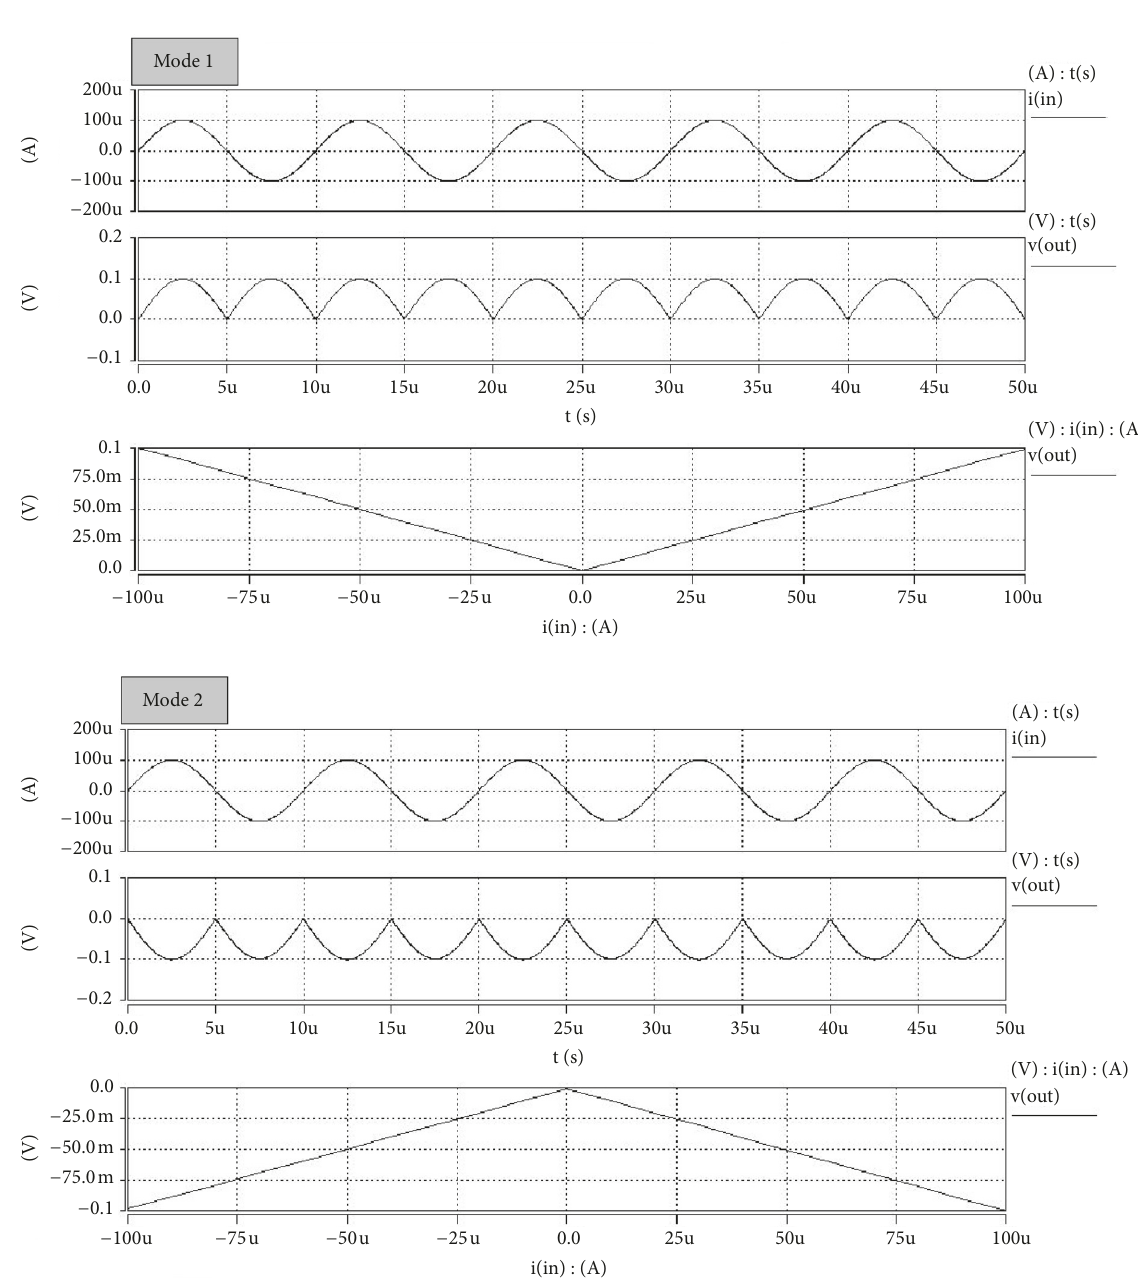
Figure 6: Simulation results of the input and rectified output waveforms and the corresponding input and output transfer characteristics of the circuit (Figure